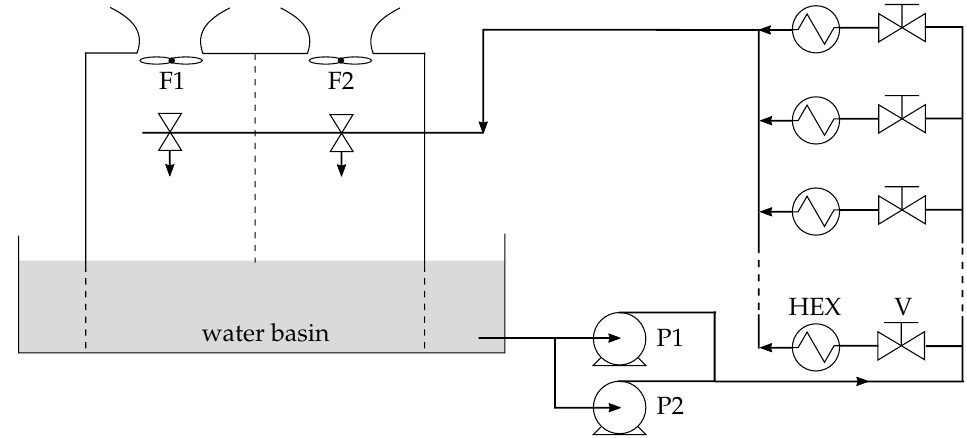
Figure 2. Simplified graphical representation of an induced draft evaporative cooling